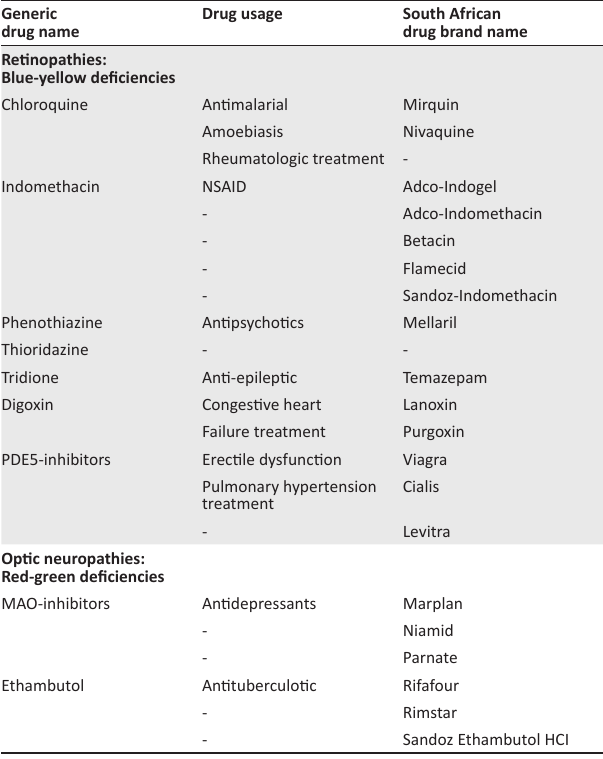
TABLE 2: Effects of drugs on colour vision. Generic drug name